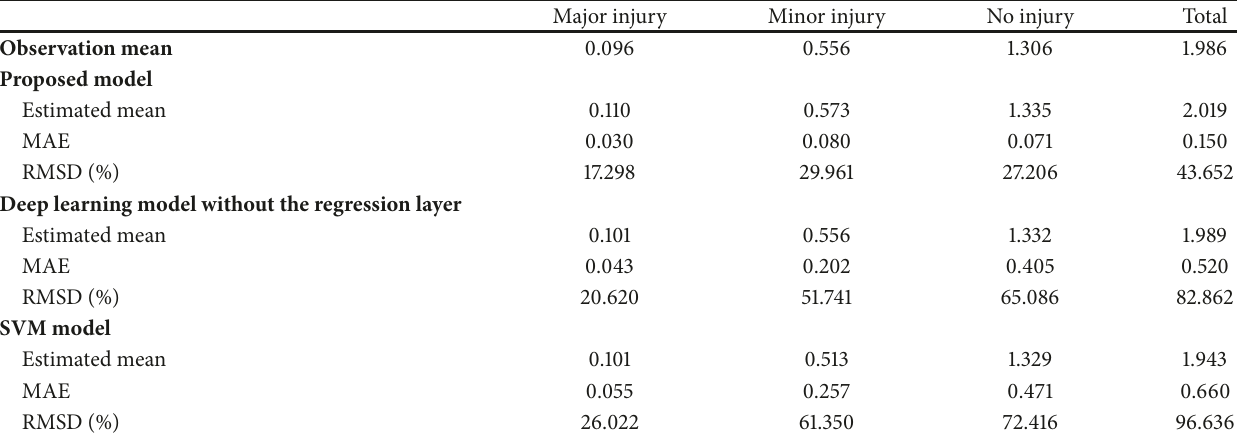
Table 6: Results of roadway segment crash count